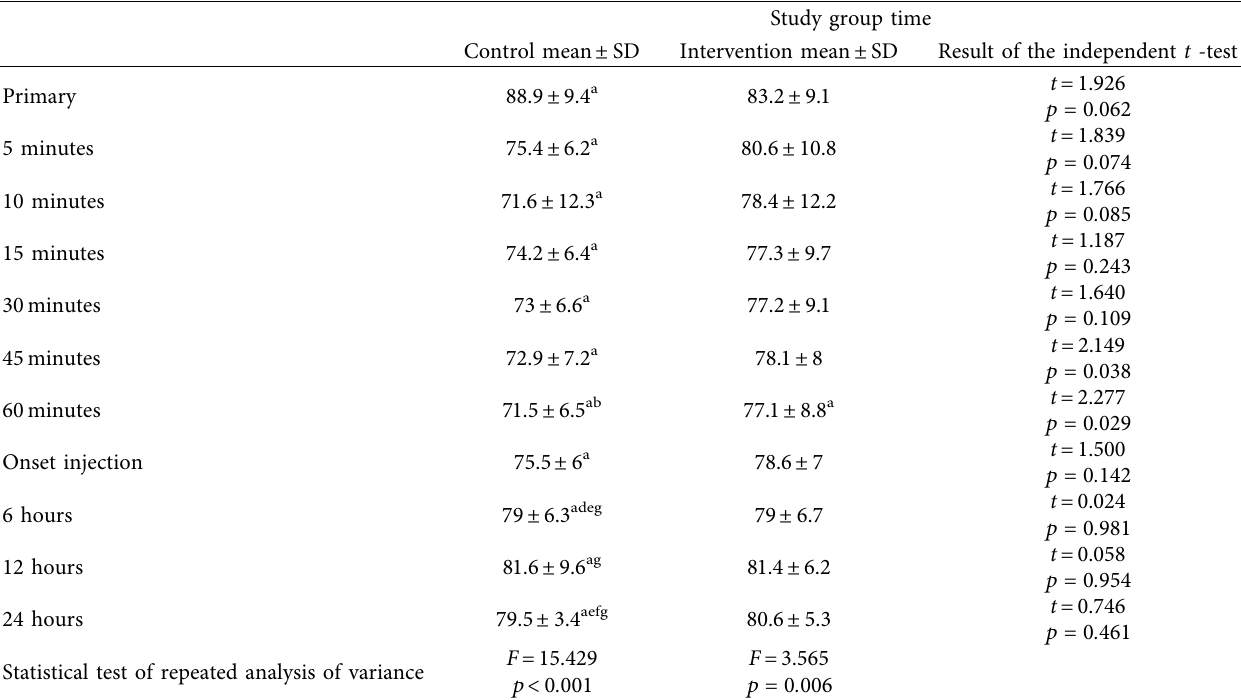
Table 5: Comparison of the average heart rate of two groups at diferent